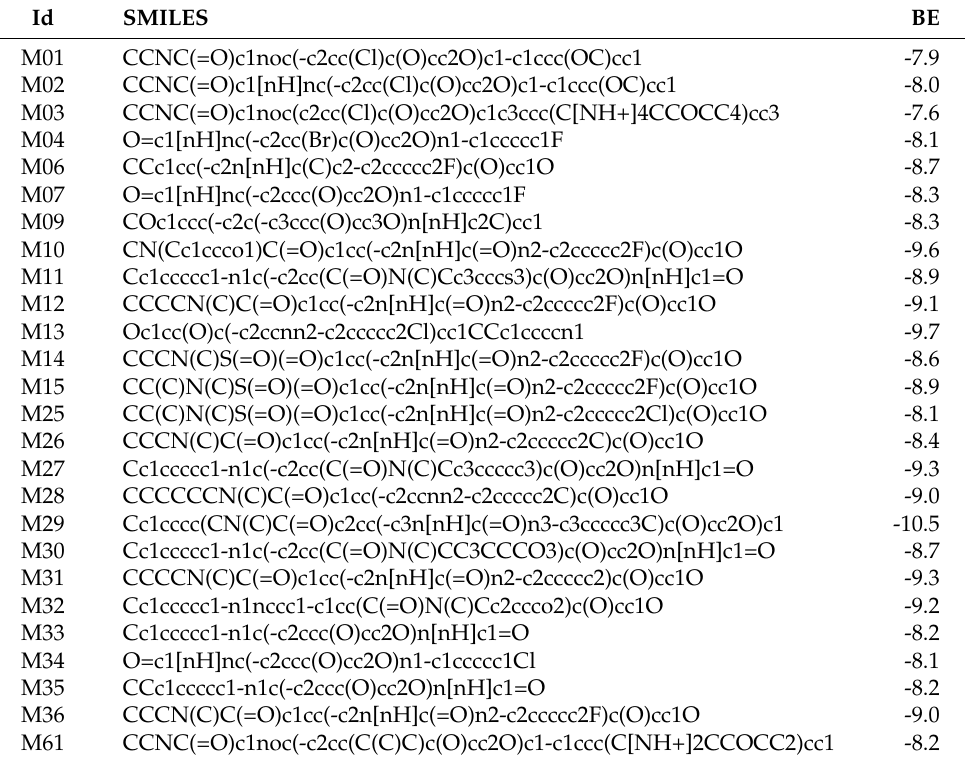
Table 1. Hsp90 inhibitors: resorcinol